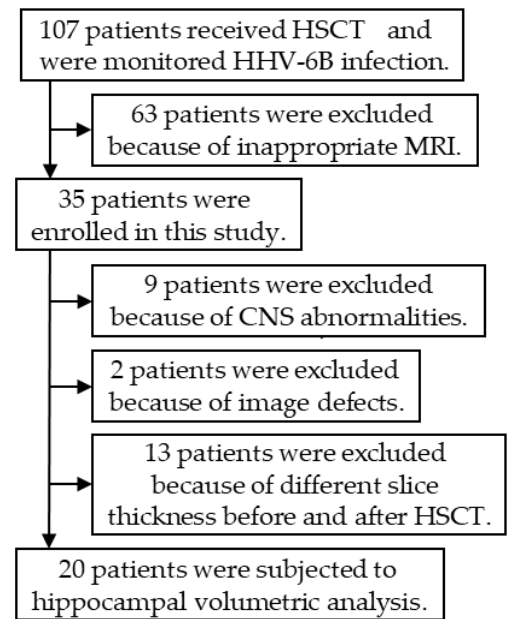
Figure 1. Flow chart of the inclusion and exclusion criteria for hippocampal volumetric analysis. HHV-6B, human herpesvirus 6B; HSCT, hematopoietic stem cell transplant.